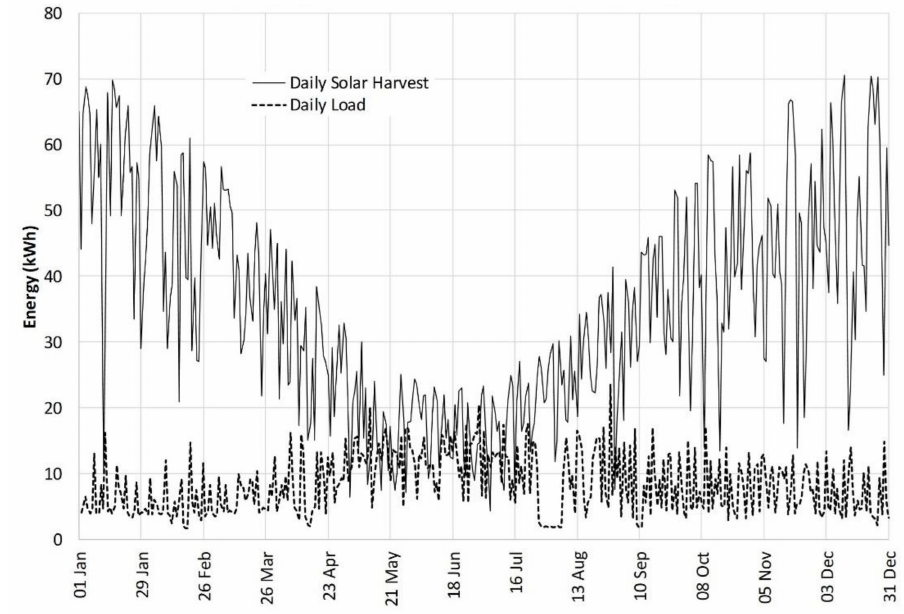
Figure 11. Daily 10 kW PV solar harvest and load for House